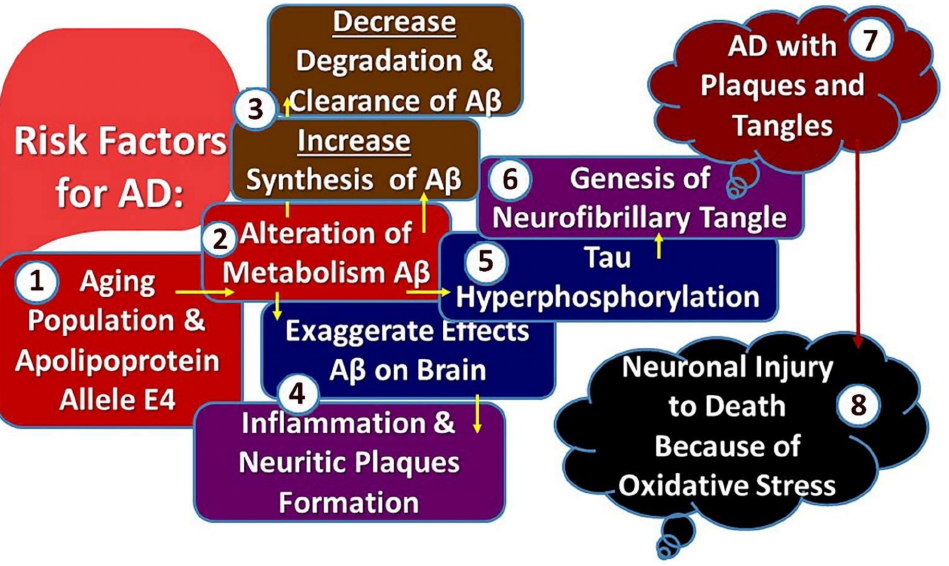
Figure 2. Illustrating Pathogenesis of Alzheimer’s Disease. Notes: Number within the figure denotes the sequences of Pathogenesis of